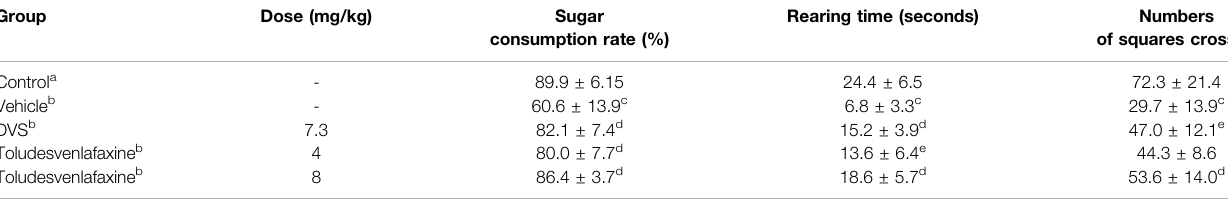
TABLE 2 | Effects of toludesvenlafaxine on the Locomotor activity and sugar consumption in CUMS rats. Group Dose (mg/kg) Sugar consumption rate (%)